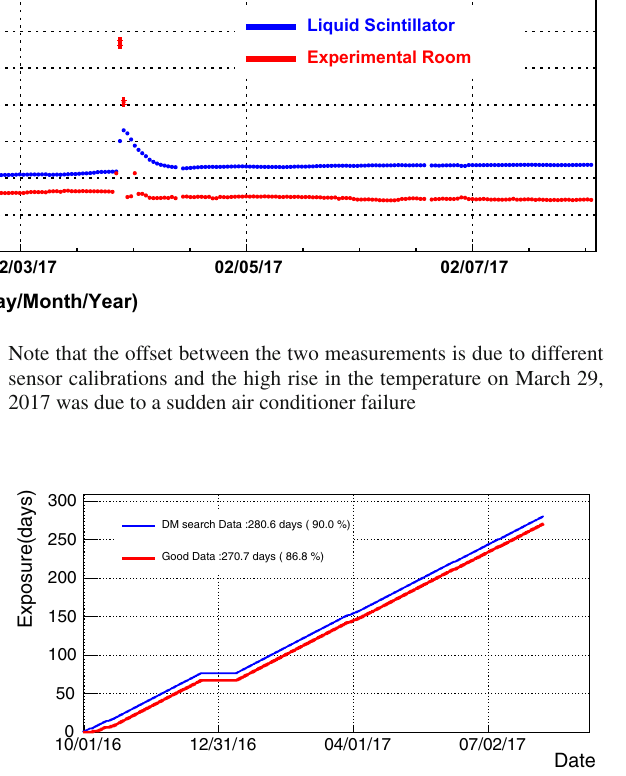
Fig. 14 COSINE-100 exposure versus date. The detector stably col- lects physics data with a 90% live time, of which 96% is high-quality. Short instabilities at the beginning of the physics data-taking are mainly due to temperature fluctuations in the vicinity of the crystals and DAQ tests. The data taking was interrupted on December 20, 2016 for a 2- week long calibration campaign with external radioactive